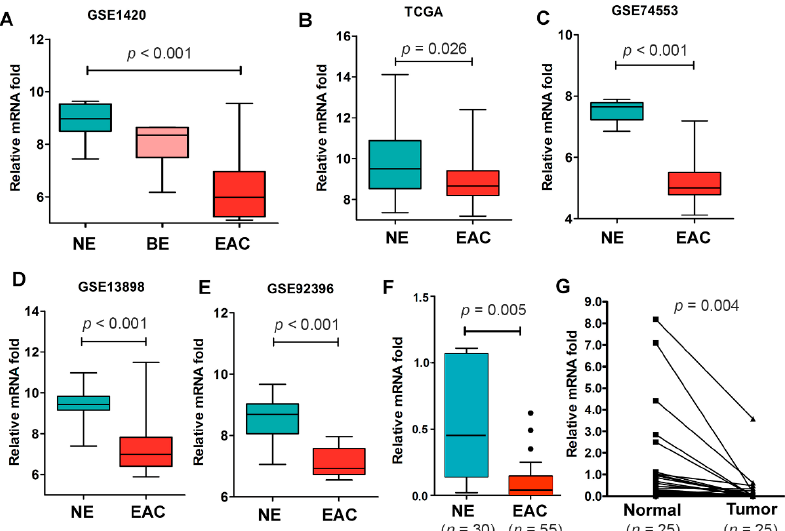
Figure 2. N-myc downregulated gene 4 (NDRG4) expression was frequently downregulated in Barrett’s